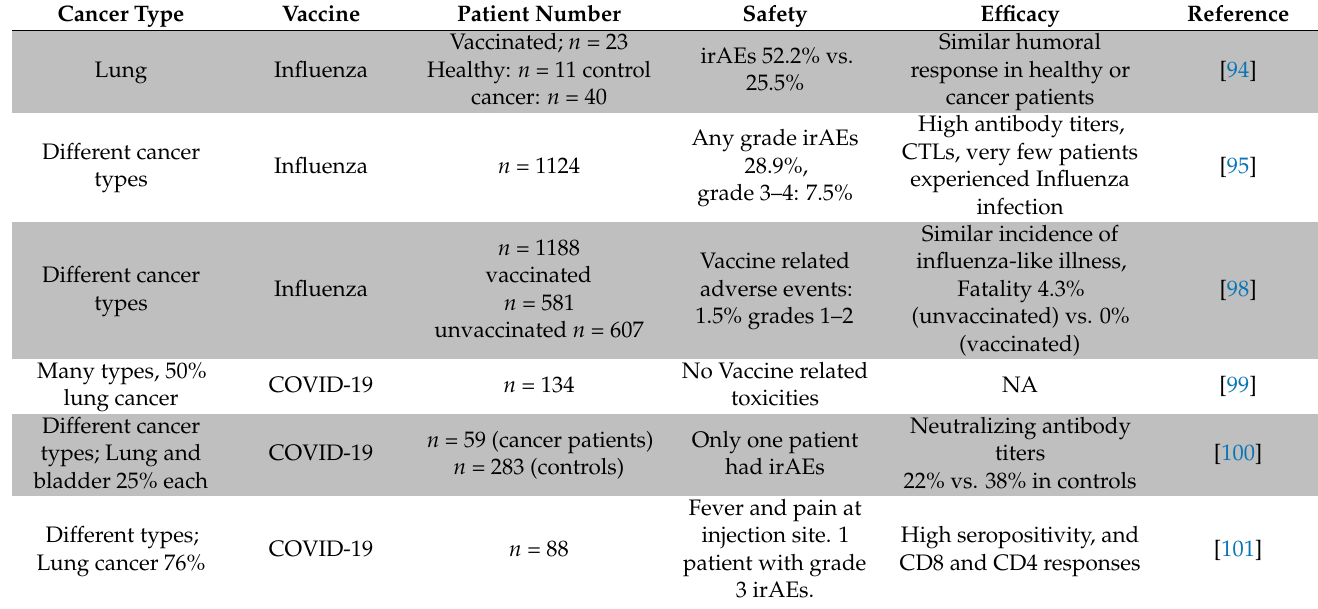
Table 3. Summary of irAEs and immune responses after vaccinations in cancer patients undergoing ICI. Cancer